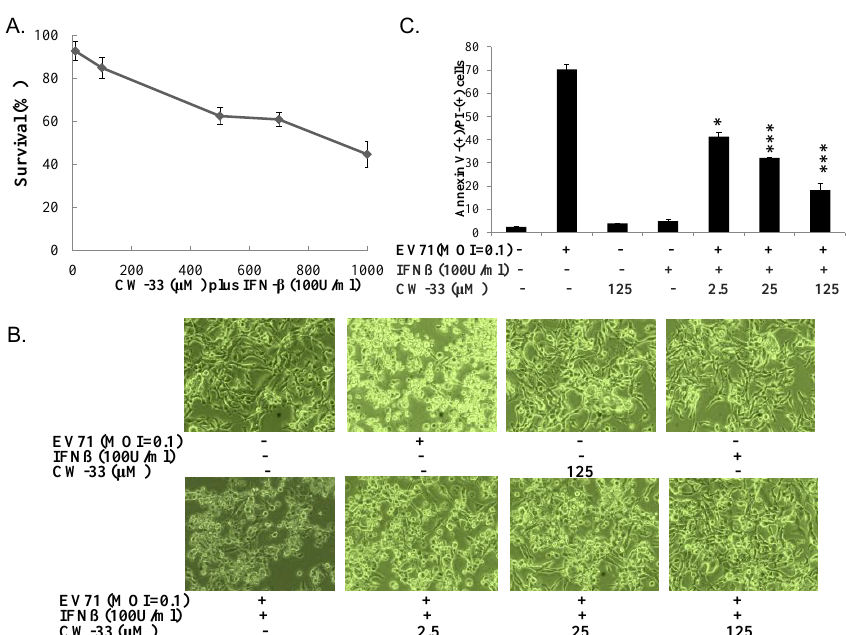
Figure 4. Inhibitory effect of CW-33 in combination with IFN-β on EV-A71-infected cytopathic effect. Firstly, cytotoxicity of CW-33 in combination with IFN-β to RD cells was performed using MTT assays ( A ). RD cells infected with EV-A71 were forthwith treated with CW-33 alone and in combination with IFN-β. Virus-induced cytopathicity was photographed post-infection by phase-contrast microscopy ( B ), apoptosis of infected and/or treated cells analyzed by flow cytometry with Annexin-V/PI staining ( C ). * p value < 0.05; *** p value < 0.001 by Scheffe test.